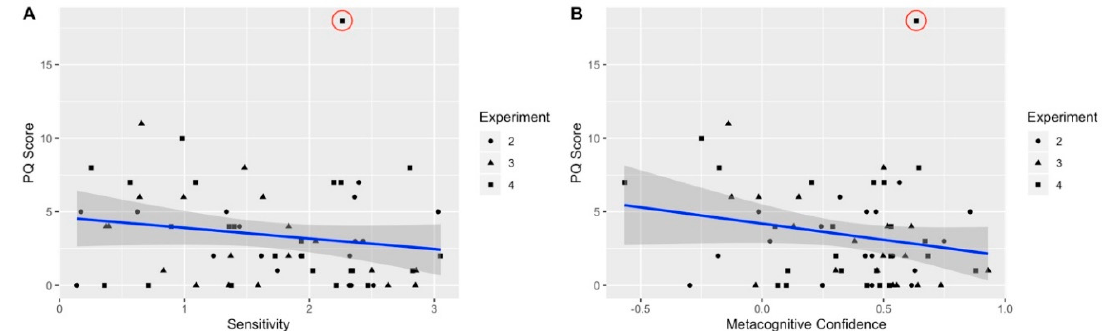
Figure 4. Correlation between APS and sensitivity ( A ) and metacognitive confidence ( B ) across the three experiments (experiment 2–4). The blue line denotes the linear regression fit and the shaded area is 95% confidence interval of fit. A red circle surrounds the participant identified as an outlier.